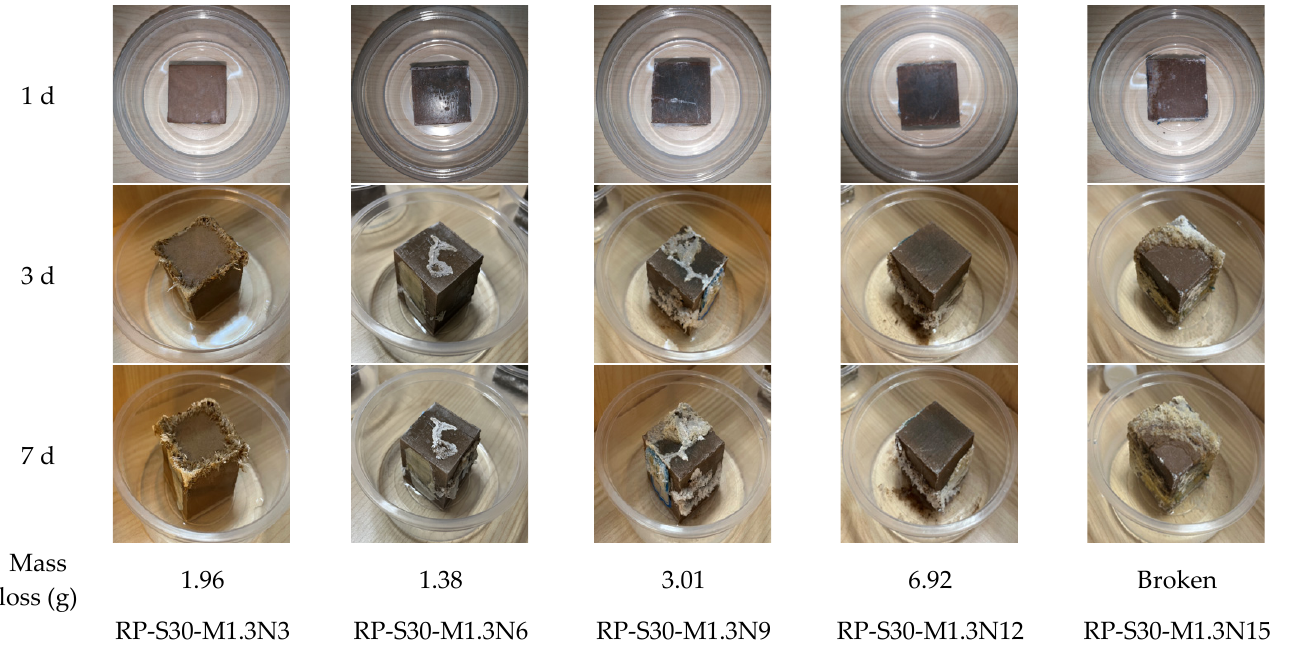
Figure 12. Visual efflorescence of RPSG with different alkali equivalents.